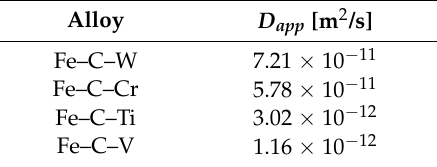
Figure 4. Normalized permeation transients for the different materials. Table 2. Hydrogen diffusion coefficients of the different materials.